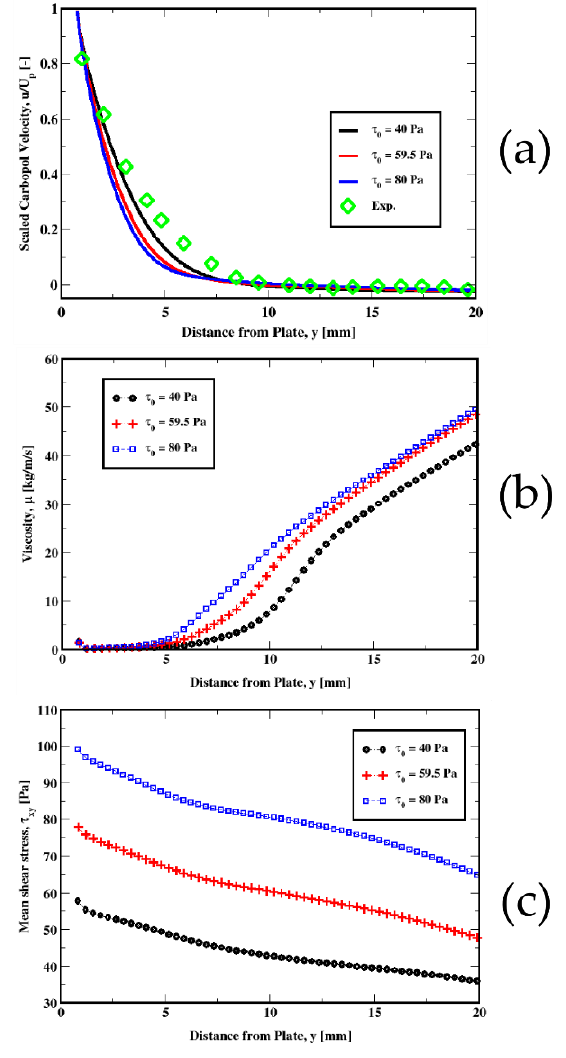
Figure 11. Influence of the yield stress on the distribution of the velocity (top plot) ( a ) for the plate immersion velocity of 1 mm/s. The middle ( b ) and the bottom ( c ) plots represent the variations in the kinematic viscosity and the mean shear stress, respectively.